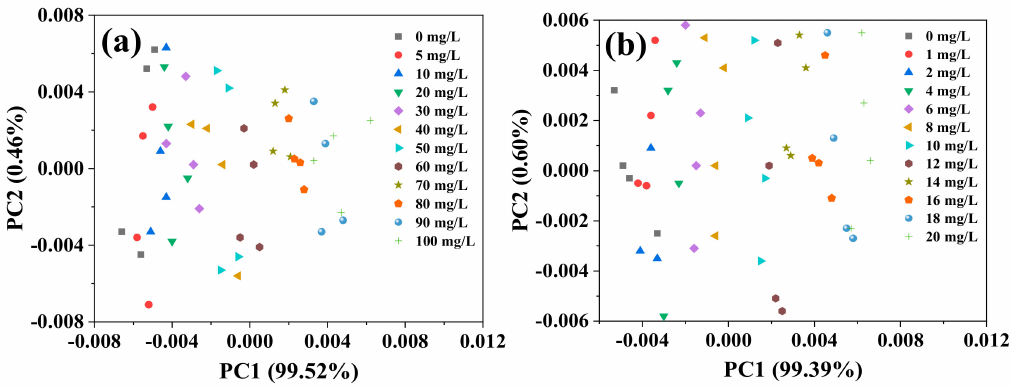
Figure 3. Principal component distribution of FTIR-ATR spectra of the nitrate solution after deconvolution (( a ) high-concentration group; ( b ) low-concentration